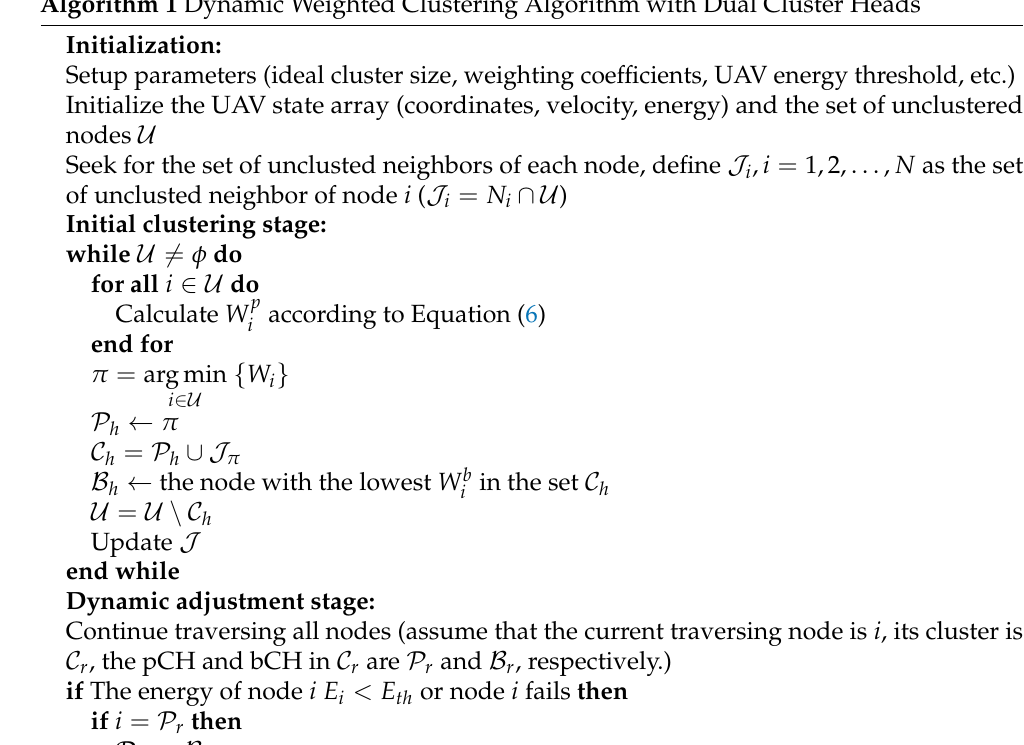
Algorithm 1 Dynamic Weighted Clustering Algorithm with Dual Cluster